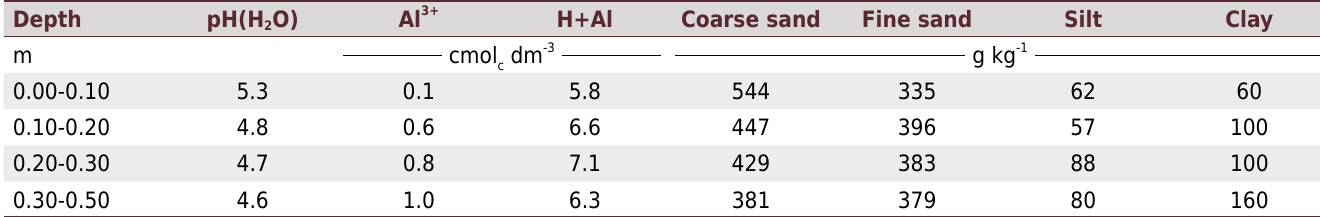
pH in water at a ratio of 1:2.5 v/v; H + and Al 3+ extracted with KCl 1 mol L -1 ; particle-size distribution determined by the Pipette method (Ruiz, 2005). Source: Rangel-Vasconcelos et al.